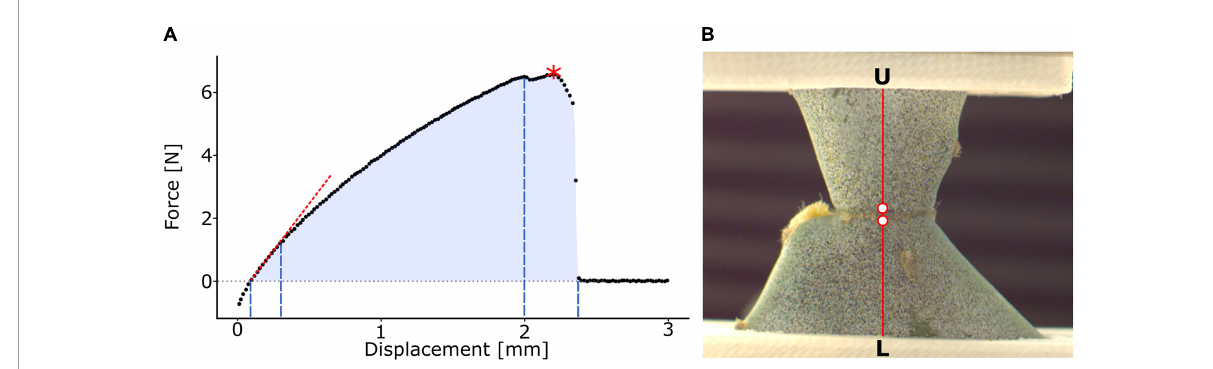
FIGURE2 Analysis of tensile test and local surface strains. (A) Exemplary illustration of a force-displacement curve. The slope of the first linear intercept as a measure for the tensile stiffness k (red dotted line), the point of maximum force F max (red asterisk), and work of fracture W (light blue area) are indicated. The division into the elastic range (first to second dashed blue line), viscoelastic plastic range (second to third dashed blue line), and fracture range (third to fourth dashed blue lines) and their respective displacement ranges are marked. (B) Clamped junction of a young sample of Opuntia ficus-indica sprayed with a stochastic speckle pattern in an unloaded state. The stochastic speckles improve the surface pattern detection in digital image correlation analysis, thereby enhancing the precision of local strain quantification. The section for detailed strain analysis is marked in red and extends from the lower clamps (L) to the upper clamps (U). The two points, directly basal and apical to the junction, used for junction strain ε j analysis are highlighted as red dots with a white